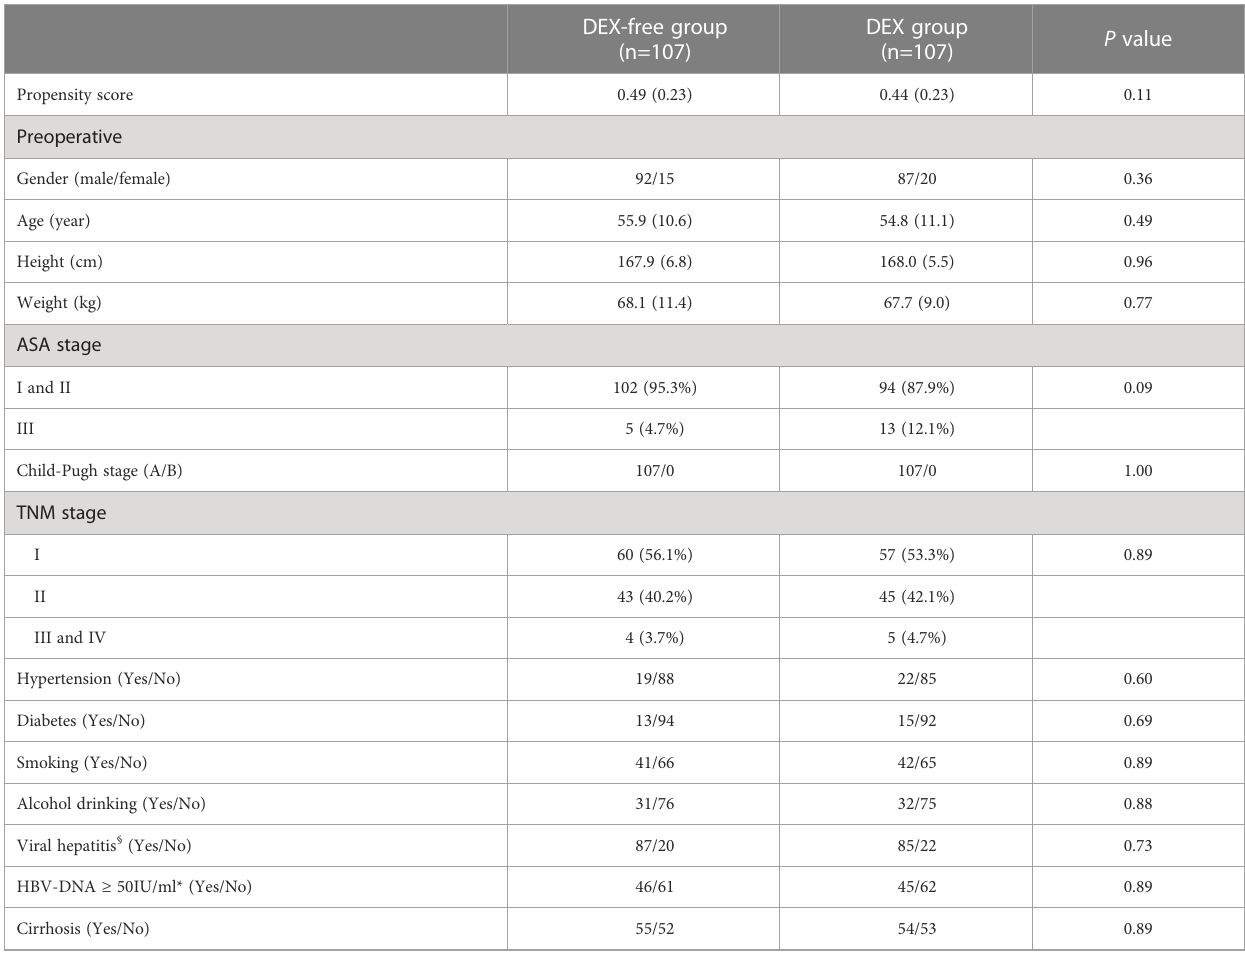
TABLE 2 Clinical characteristics of HCC patients between two groups after